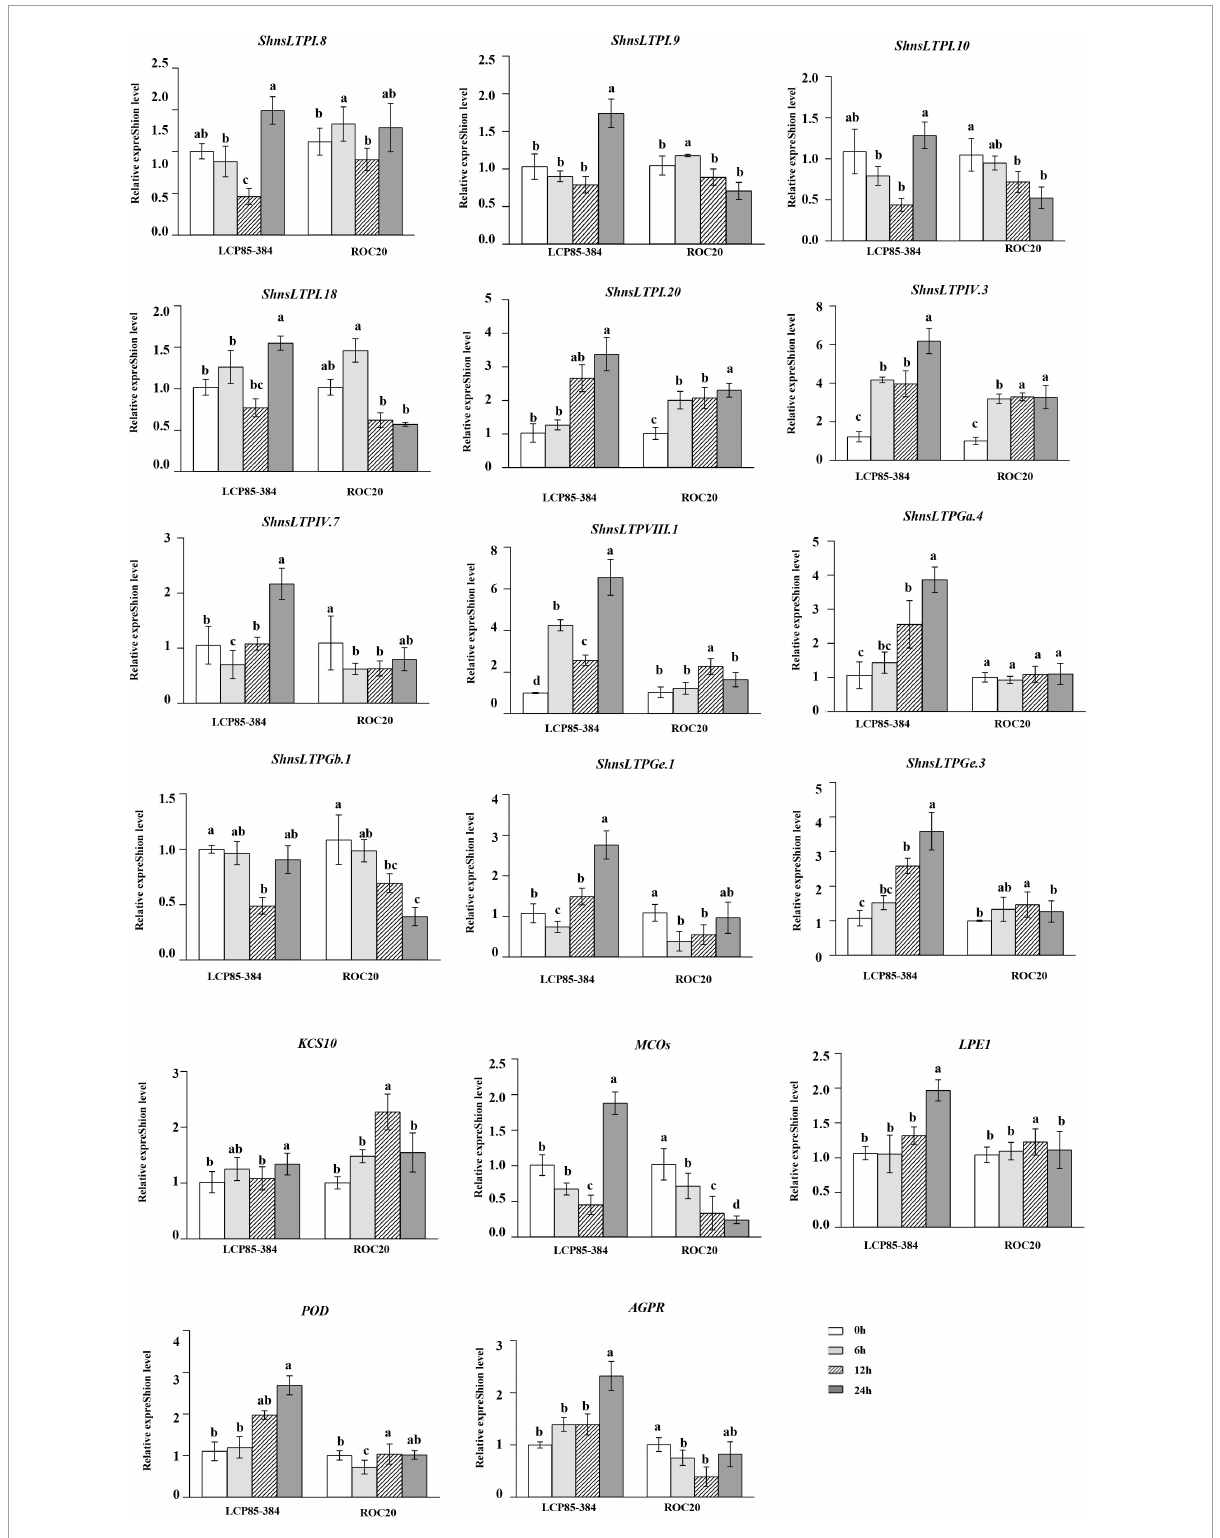
FIGURE7 Transcript expression levels of 12 ShnsLTPs and 5 interacting protein genes in LCP85-384 (resistant to leaf scald) and ROC20 (susceptible to leaf scald) sugarcane cultivars after exogenous salicylic acid treatment. The bars indicate mean ± SD ( n = 9). The same letters indicate no significant difference ( p >